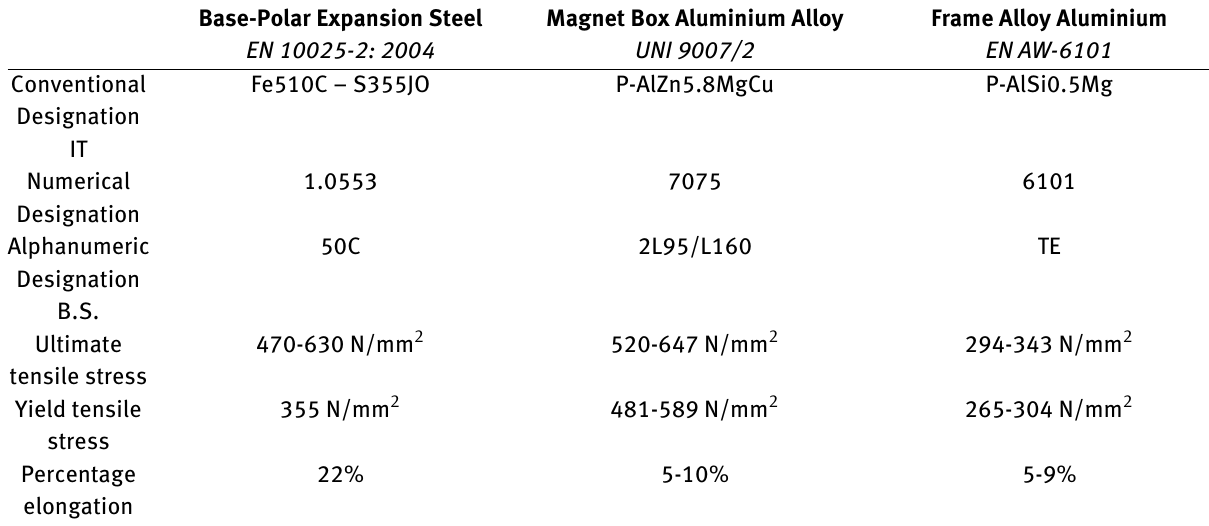
Table 1: Material Used to Manufacture the